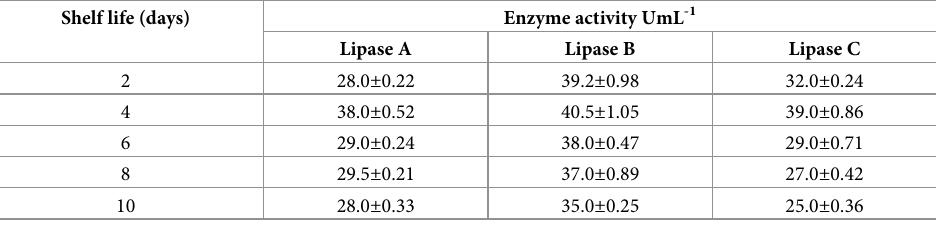
Table 4. Effect of fermentation period on lipase production from B . cereus NC7401 cultured using starch (Lipase A), maltose (Lipase B), and tryptone (Lipase